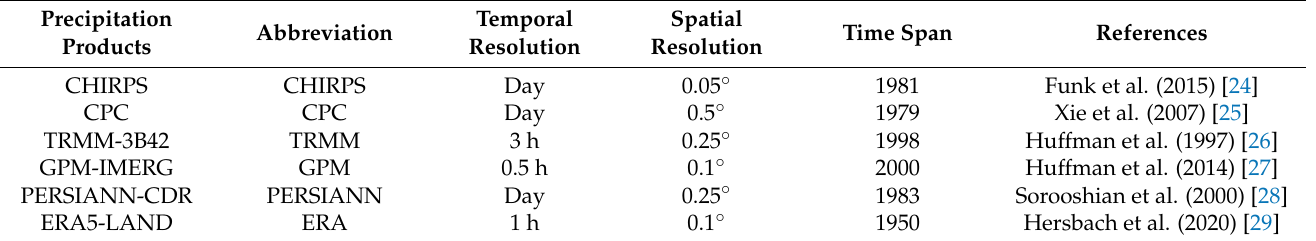
Table 1. Multisource precipitation product information.